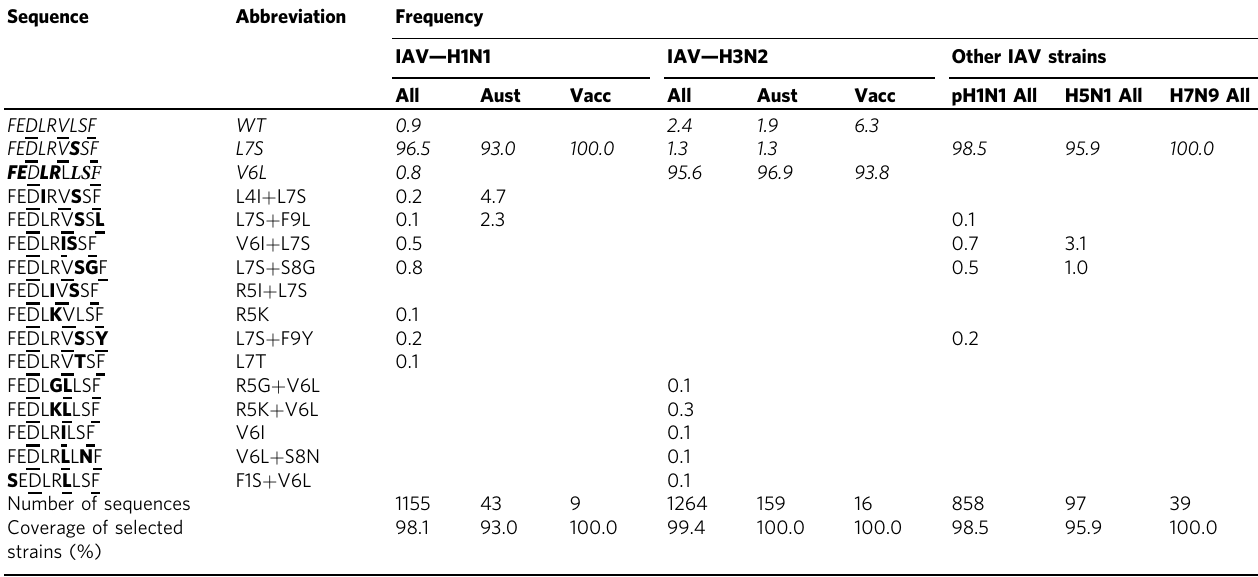
Table 2 Conservation of NP 338 epitope in distinct IAV strains